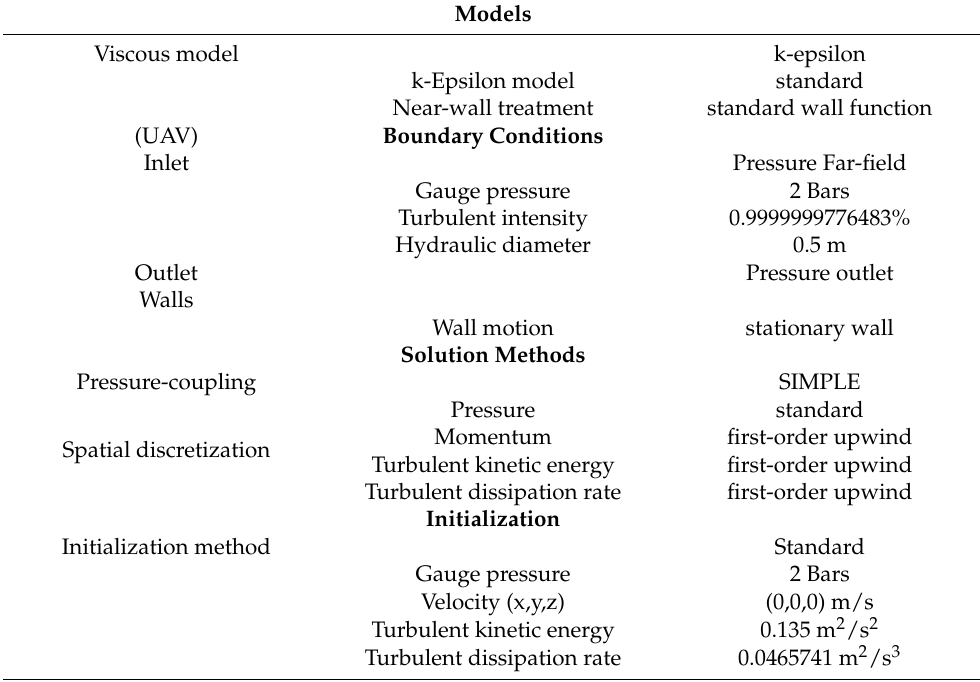
Table 4. The following table defines the steps of the problem and its